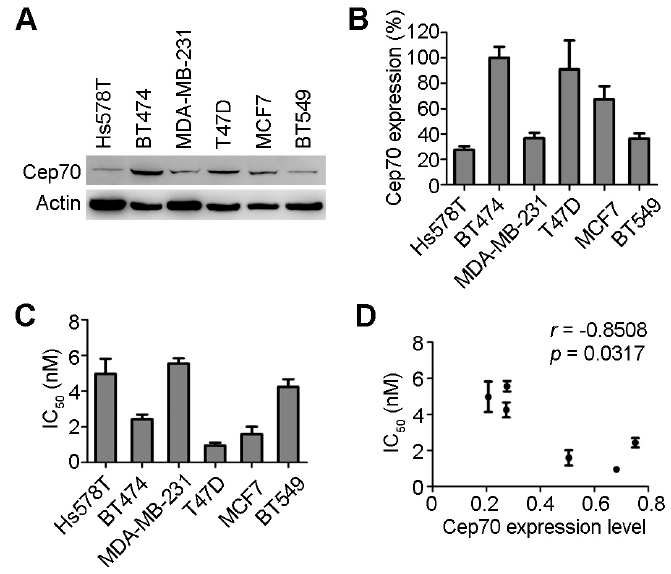
Figure 1. Centrosomal protein 70 (Cep70) expression and paclitaxel sensitivity in breast cancer cells. ( A ) The protein expression levels of Cep70 and actin in human breast cancer cells were examined by immunoblot analysis; ( B ) Experiments were performed as in ( A ), and the level of Cep70 expression in breast cancer cell lines was quantified by measuring the intensity of immunoblot band with Image J software (National Institutes of Health). Actin level was used as an internal control. The value of y -axis showed Cep70 expression level in different cancer cells as a percentage of that in BT474 cell; ( C ) The breast cancer cells were treated with paclitaxel for 48 h, and the IC 50 values were then examined by cell proliferation assay; ( D ) Experiments were performed as in ( C ), and the relationship between IC 50 and the expression level of Cep70 was analyzed by Spearman rank correlation test. All data are presented as means ± standard deviations (SD), n = 3 per group.